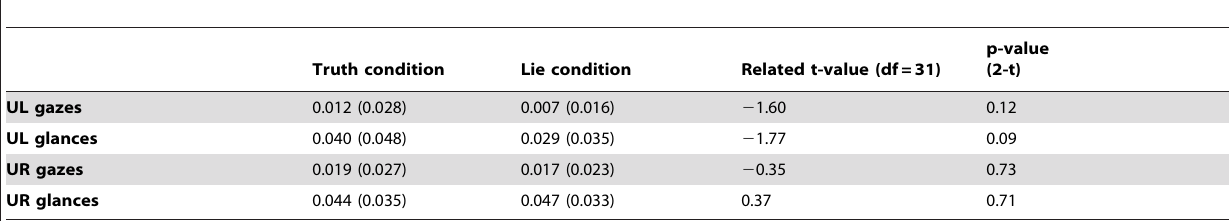
Table 1. The mean frequencies (per second, SD in parentheses), related t-tests and p-values comparing of UL and UR gazes and glances in the Truth and Lie